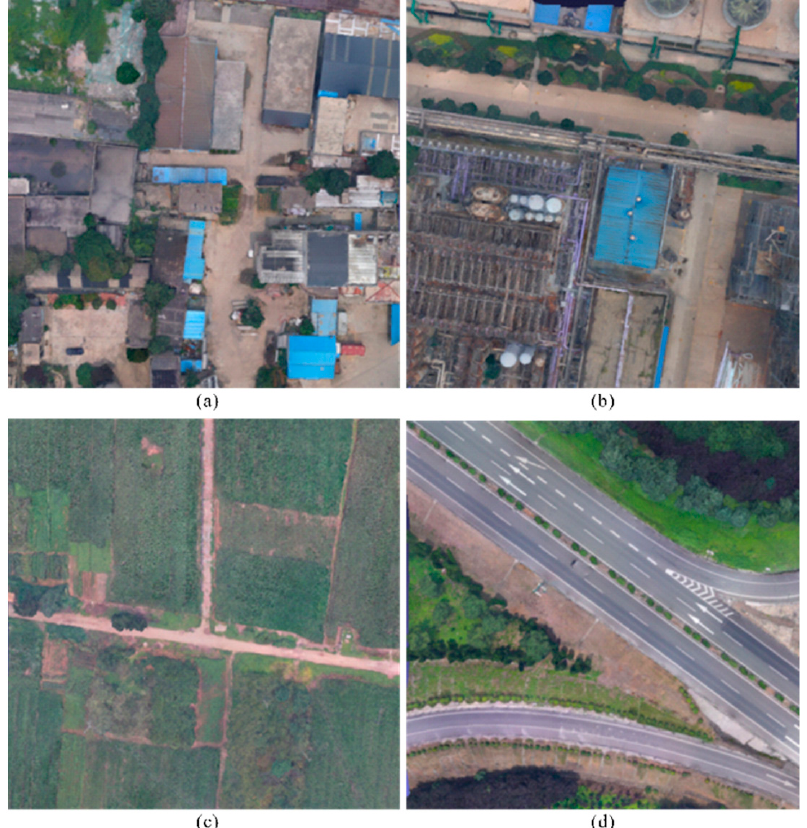
Figure 14. Four types of 3D models of different areas. ( a ) Residential areas. ( b ) Factory areas. ( c ) Vegetation areas. ( d ) Road areas. Table 2. Data size statistics. The data size (mesh, texture) after the proposed algorithm and the tra- ditional algorithm are simplified under different simplification parameters are counted, and the unit is kb. ( a ) Residential areas. ( b ) Factory areas. ( c ) Vegetation areas (farmland for example). ( d ) Road areas (highways for example).